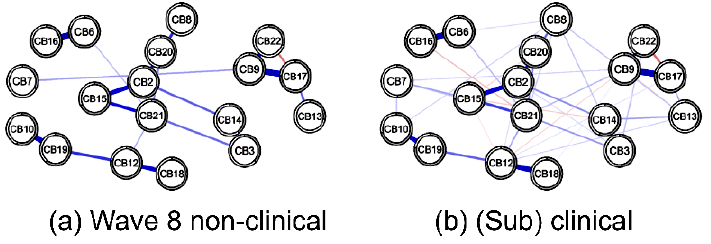
Figure 6. Comparison of CBCL 18-node networks for ( a ) nonclinical and ( b ) (sub)clinical groups. The shaded rings around each node indicate predictability (%). CB1 = emotionally reactive; CB2 = anxious/depressed; CB3 = somatic complaints; CB4 = withdrawn; CB5 = sleep problems; CB6 = attention problems; CB7 = aggressive behaviors; CB8 = other problems; CB9 = DSM affective problems; CB10 = DSM anxiety problems; CB11 = DSM pervasive developmental problems; CB12 = DSM attention-deficit/hyper-activity problems; CB13 = DSM oppositional defiant problems; CB14 = withdrawn/depressed; CB15 = rule-breaking behavior; CB16 = social problems; CB17 = thought problems; CB18 = DSM somatic problems; CB19 = DSM conduct problems; CB20 = obsessive–compulsive symptom; CB21 = posttraumatic stress problems and CB22 = sluggish cognitive tempo.